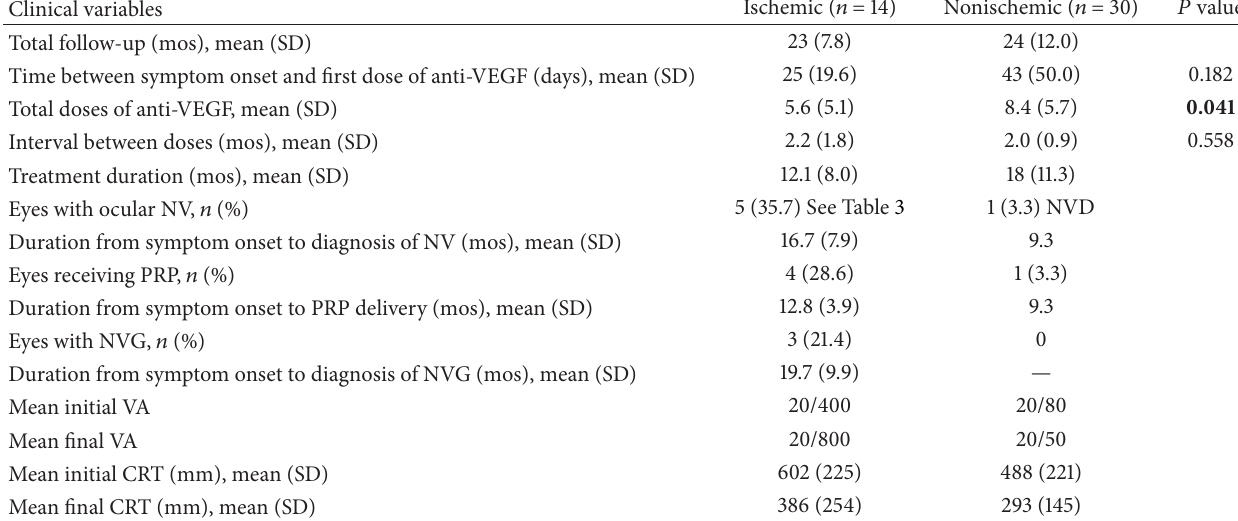
Table 2: Ocular characteristics of ischemic and nonischemic CRVO eyes receiving anti-VEGF for macular edema. Clinical variables